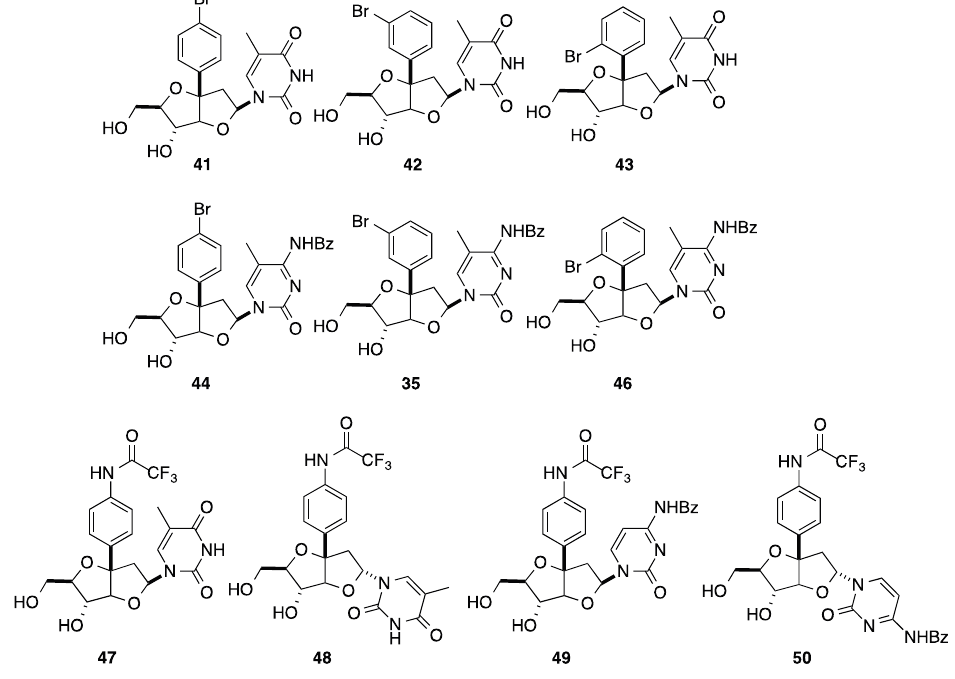
Figure 2. Bicyclo[3.3.0]octane nucleoside analogues 41 – 50 having a substituted aromatic